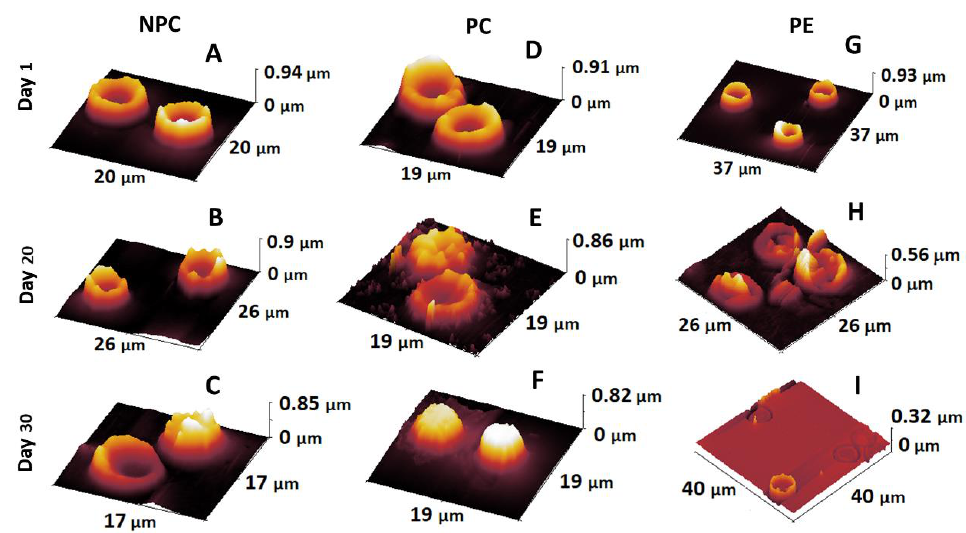
Figure 3. Selected 3D images of RBCs isolated from non-pregnant women (NPC, ( A – C )), healthy pregnant women (PC, ( D – F )), and patients with preeclampsia (PE, ( G – I )). The images show morphological changes in aging cells over a storage period of 30 days.